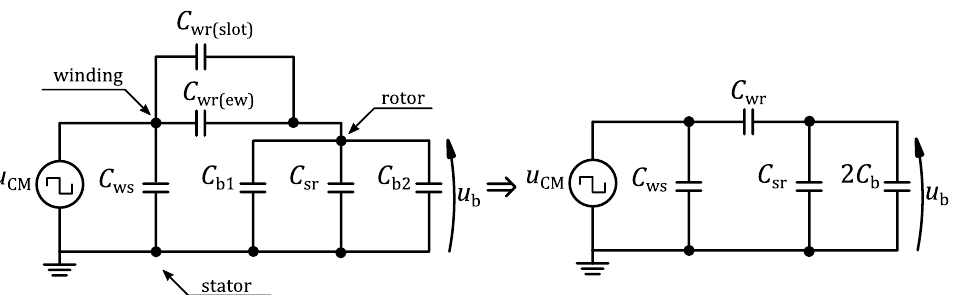
Figure 4. Distribution of parasitic capacitances in an electric machine.